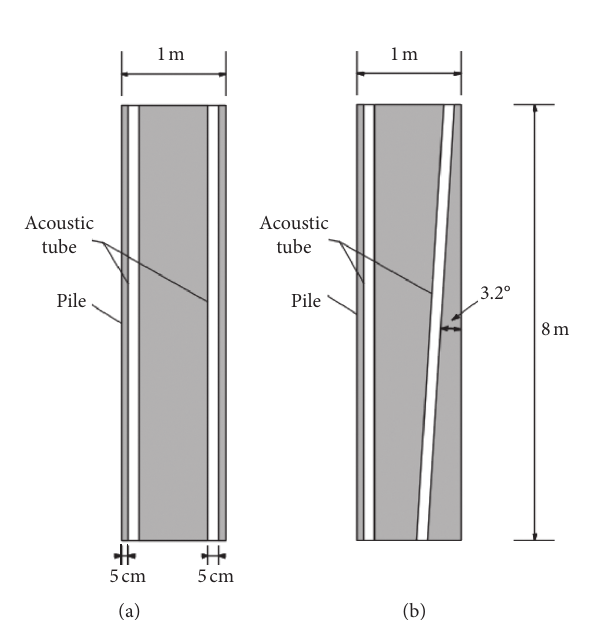
Figure 1: The model of the pile with the acoustic tube. (a) Parallel acoustic tube and (b) tilted acoustic tube.